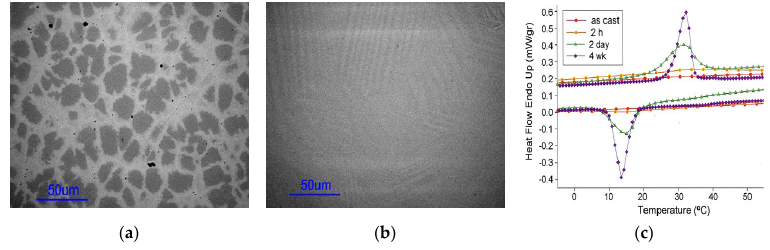
Figure 7. ( a ) As ‐ cast; ( b ) heat ‐ treated for 72 h; ( c ) differential scanning calorimetry (DSC) data showing the effect of heat treatment [76], with copyright permission from © Elsevier BV .